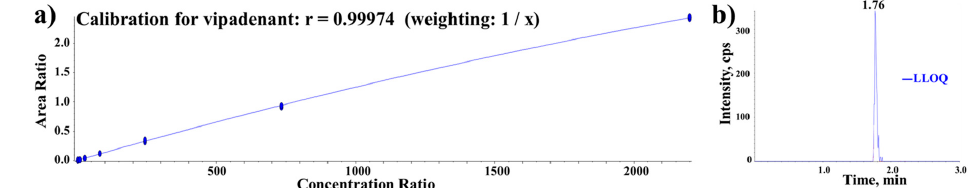
Figure 2. ( a ) Calibration curve of vipadenant and ( b ) Lower limit of quantification (LLOQ) in rat plasma.